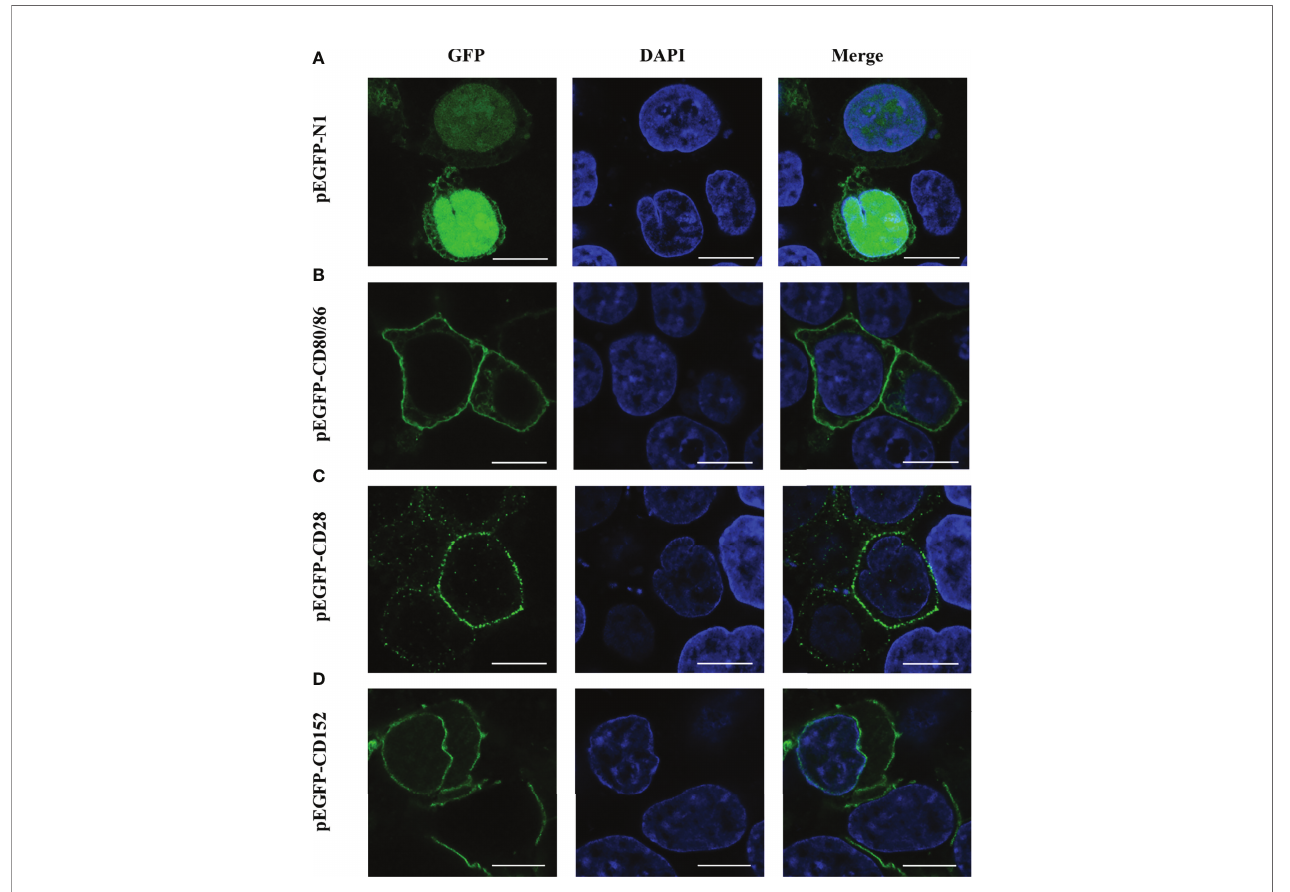
FIGURE 8 | Subcellular localization analyses of CD80/86, CD28, and CD152 in HEK293T cells. (A) HEK293T cells were transfected with a pEGFP-N1 plasmid. (B) HEK293T cells were transfected with a pEGFP-CD80/86 plasmid. (C) HEK293T cells were transfected with a pEGFP-CD28 plasmid. (D) HEK293T cells were transfected with a pEGFP-CD152 plasmid. The images were captured using a two-photon laser scanning confocal microscope (Nikon N-storm, Japan). Scale bar = 10 m m.